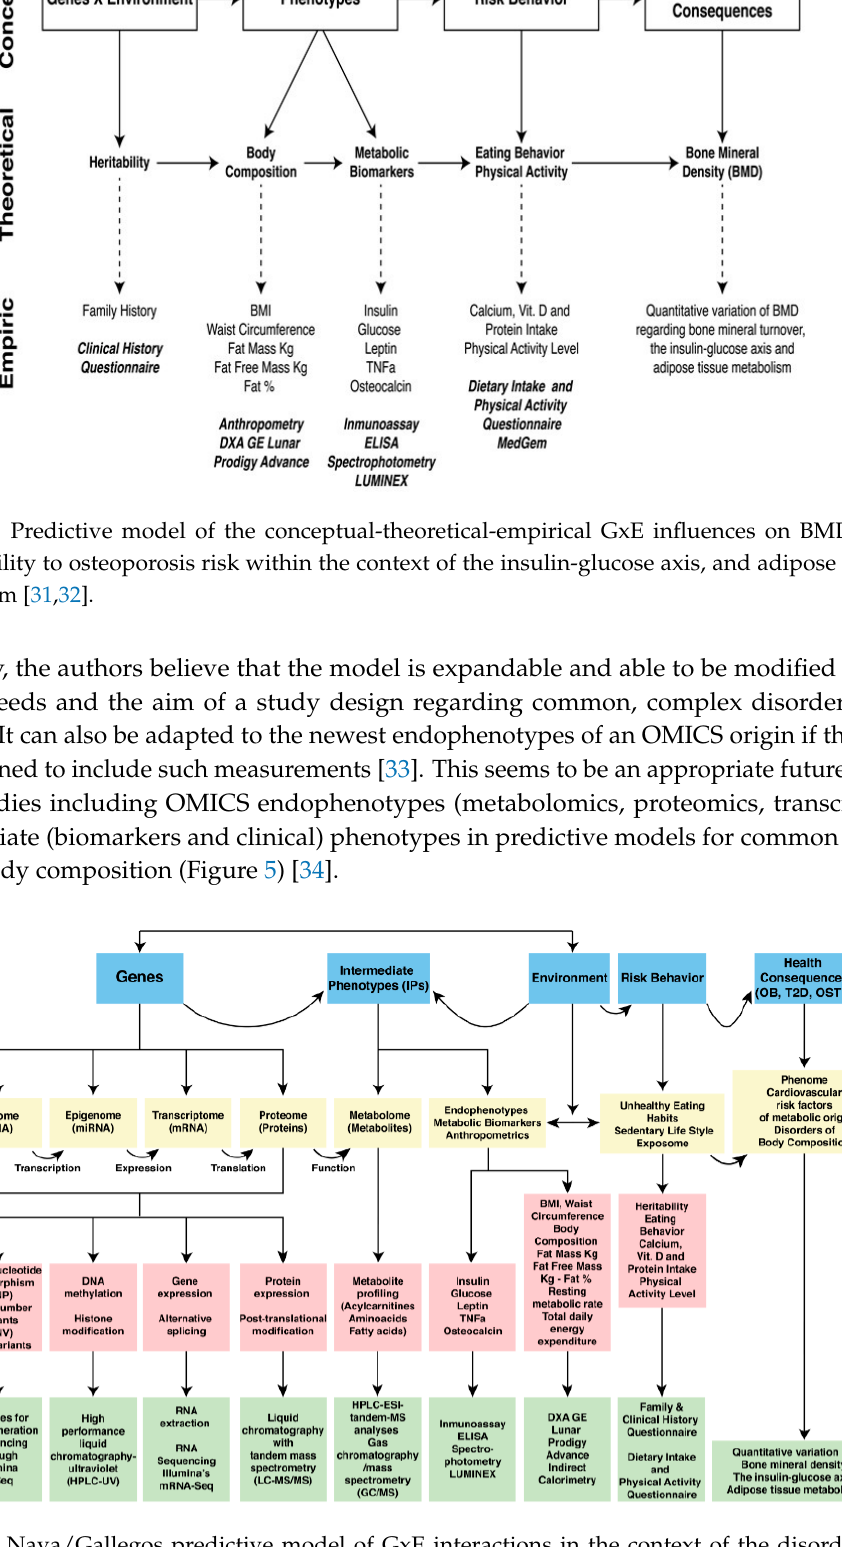
Figure 5. Nava/Gallegos predictive model of GxE interactions in the context of the disorders of body composition with the hypothetical inclusion of data to integrate intermediate phenotypes with biological systems multi-OMICS.